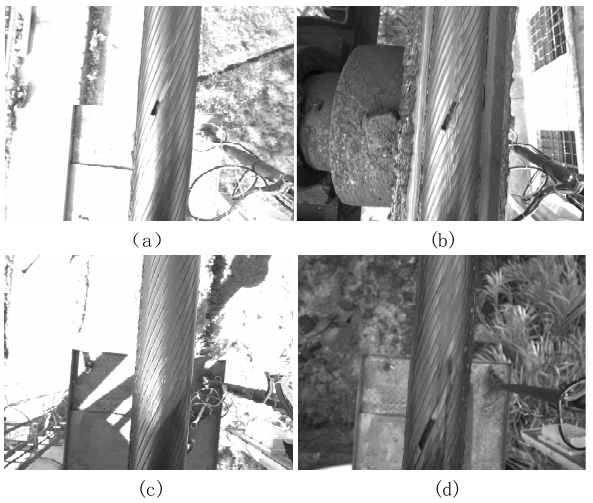
Figure 3. Complex representation of wire rope image. ( a ) Strong light and reflection; ( b ) Weak light; ( c ) Uneven light; ( d ) Oil stain on wire rope surface.